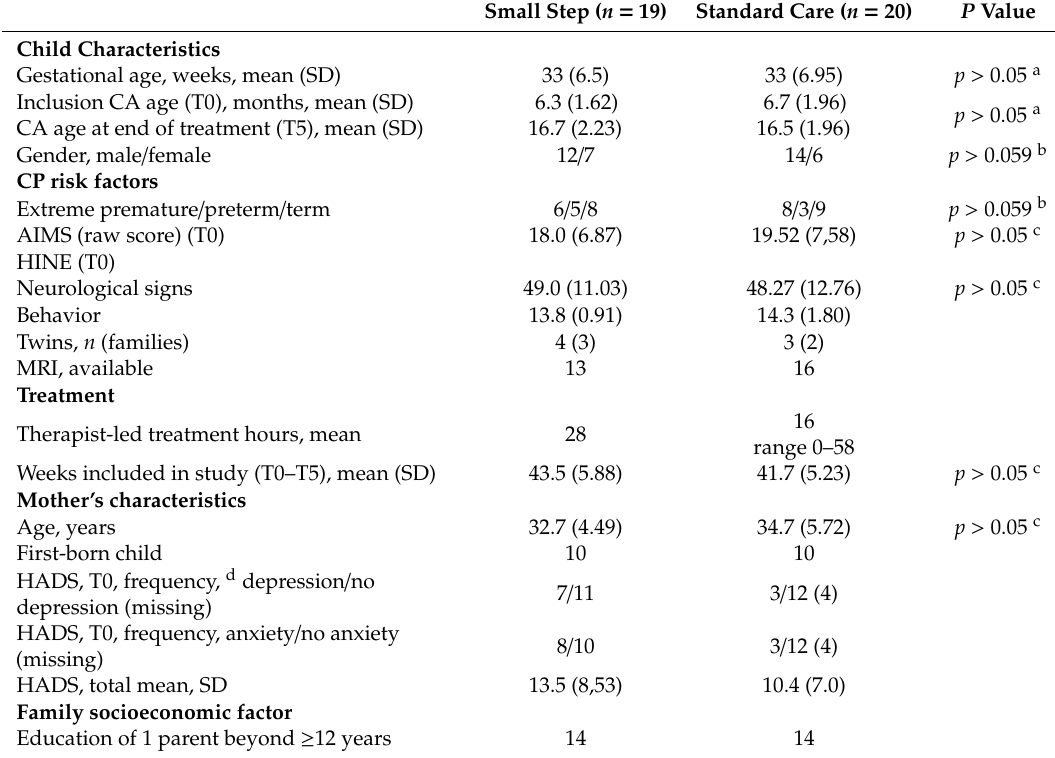
Table 1. Baseline demographic characteristics of the participants ( n =